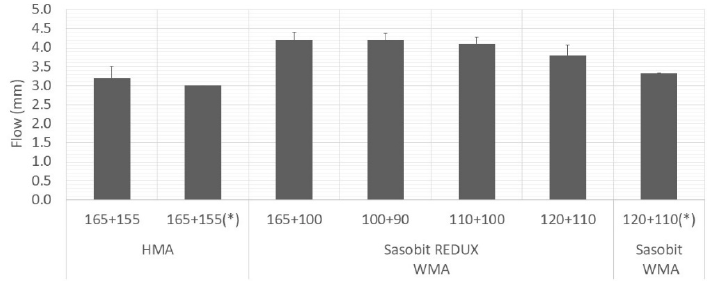
Figure 8. Variation of Marshall flow with mixture and temperature.